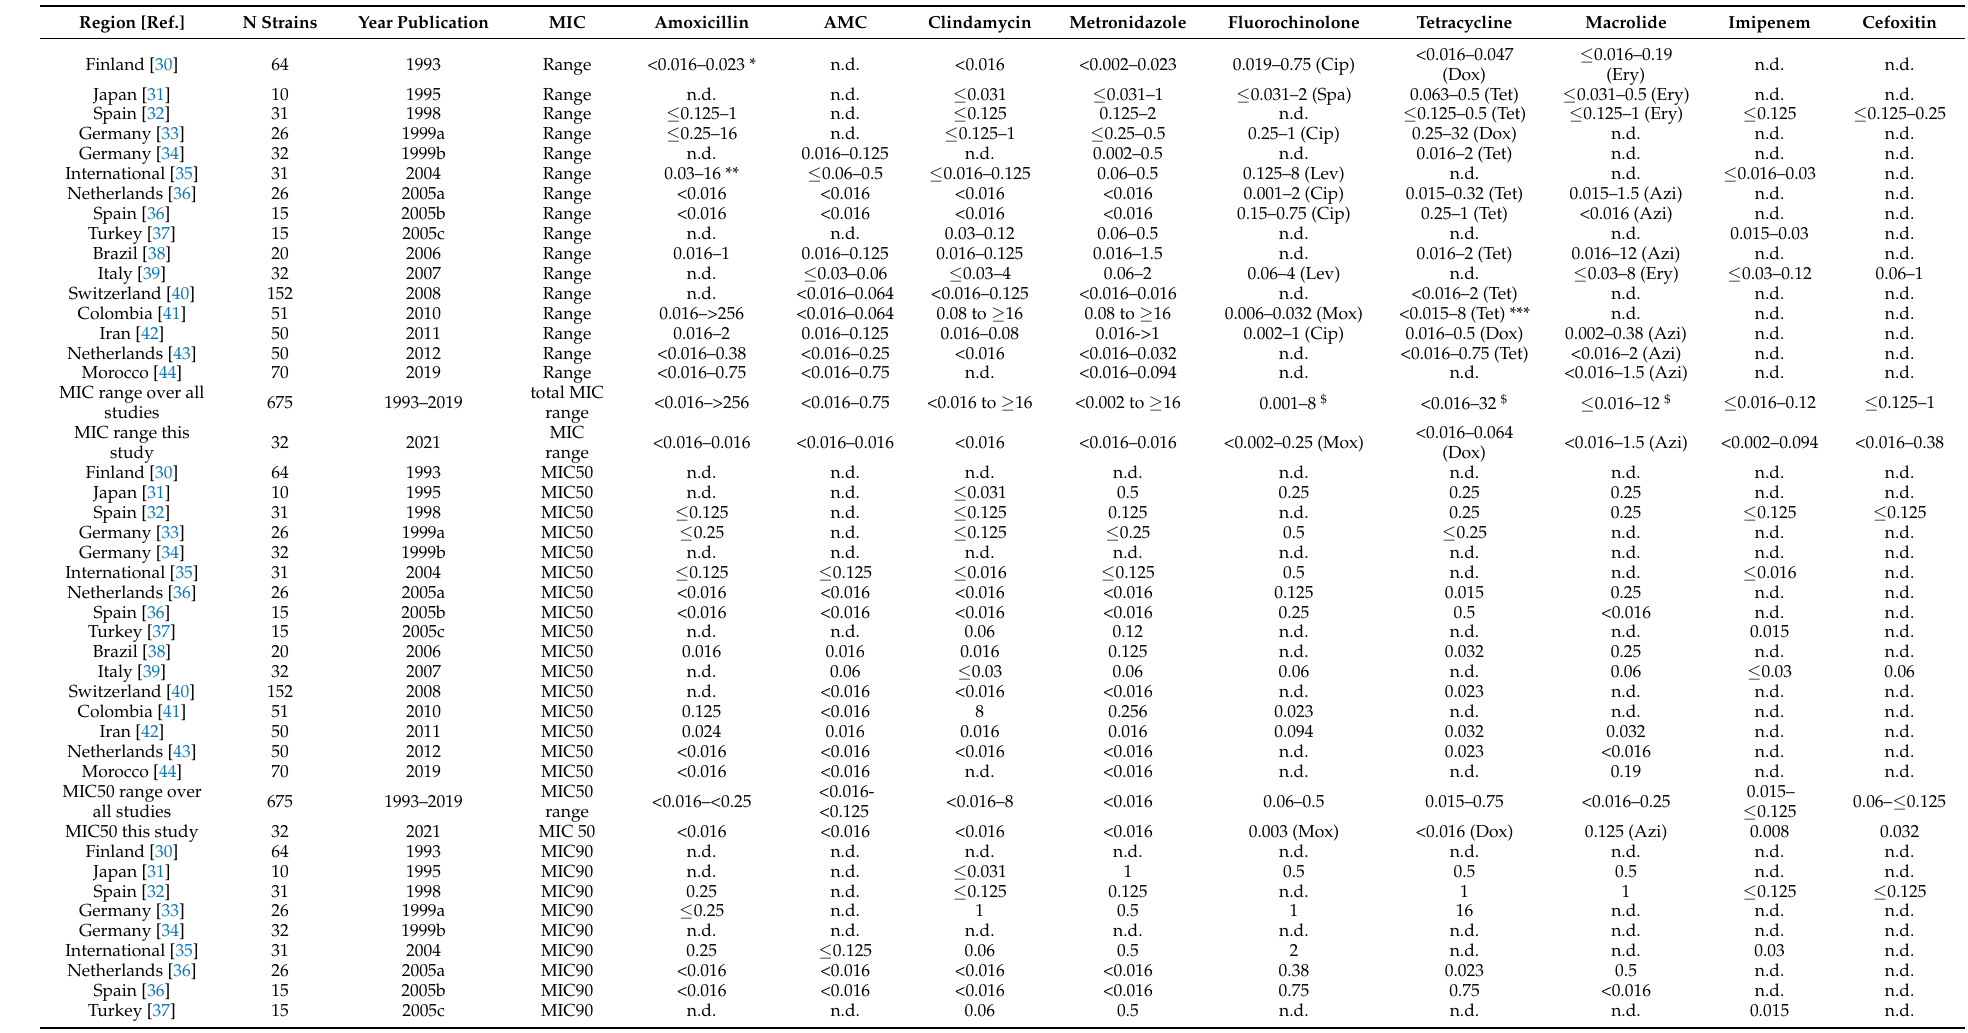
Table 3. Comparison of 16 studies (1993–2019) determining the MIC range, MIC50, and MIC90 (in mg/L) of the key periodontopathogen Porphyromonas gingivalis for 9 antibiotics (including three classes) applying different methods (see Table 2). Region